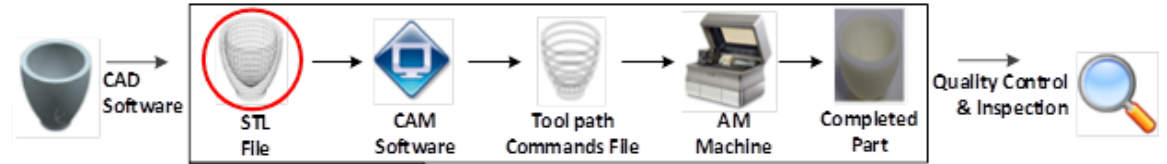
Fig. 1. Additive manufacturing procedure